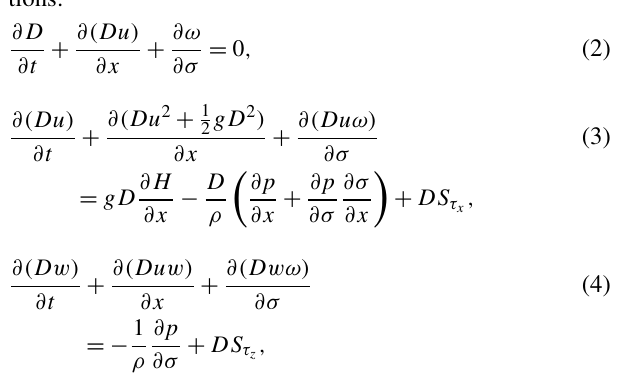
Figure 2. Top view (a) and side view (b) of two neighboring grains (white rectangles) connected with a bond (blue rectangle). Rela- tive translational and angular velocity differences relevant for the present study are shown in red (rotation in the xz plane and ver- tical displacement), while the remaining velocity components are in gray. Red dots with labels “C” and “T” in panel (b) mark the locations of maximum compressive and tensile stress, respectively, acting on the bond when the relative rotation is directed as shown in